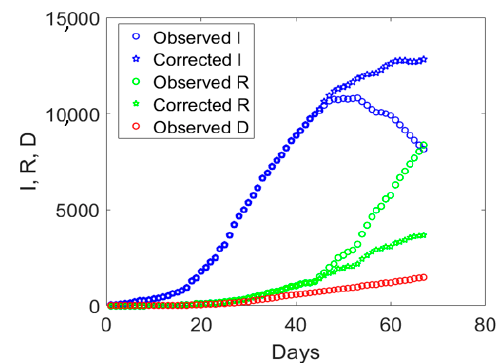
Figure 5. Observed compartments (circles) in Veneto and proposed corrected values based on the ratio between the daily total number of medical swabs over the number of actual infected individuals